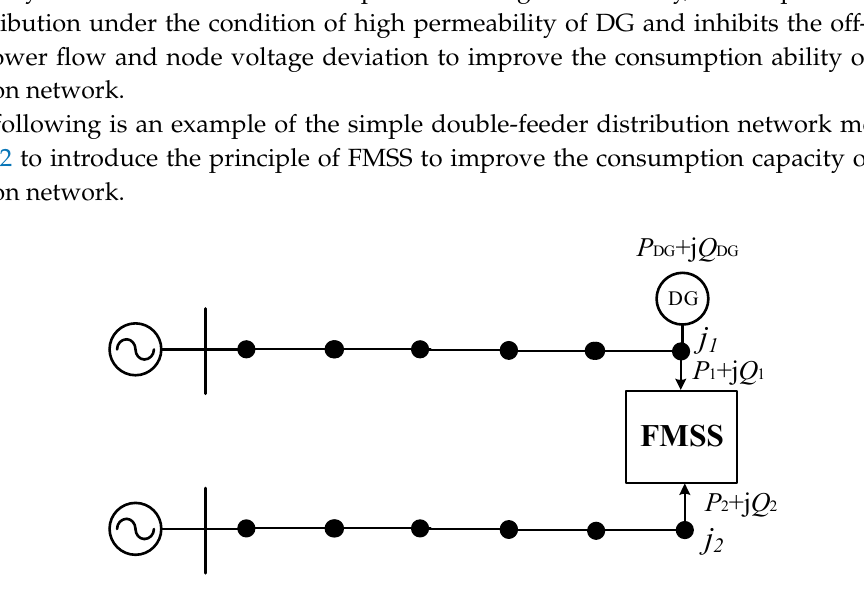
Figure 2. Simple uniform distribution network system with DG.